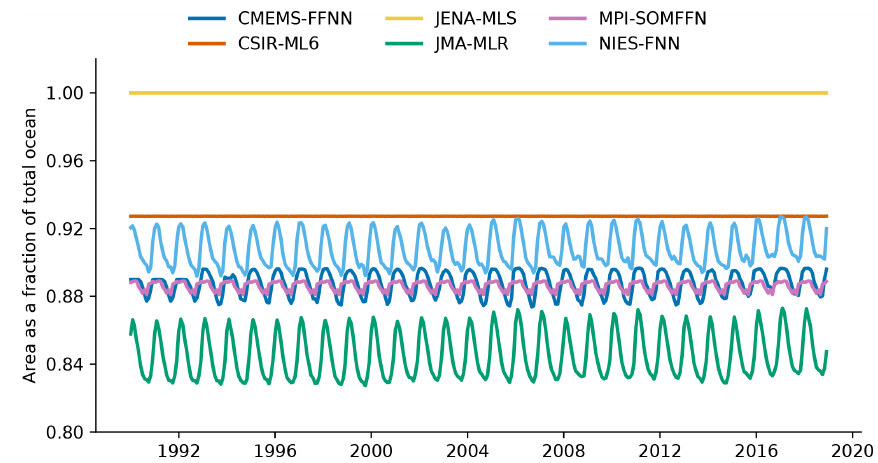
Figure A1. Time series showing the fraction of area covered by observations as a function of time (monthly) for the six p CO 2 data products used in this study.